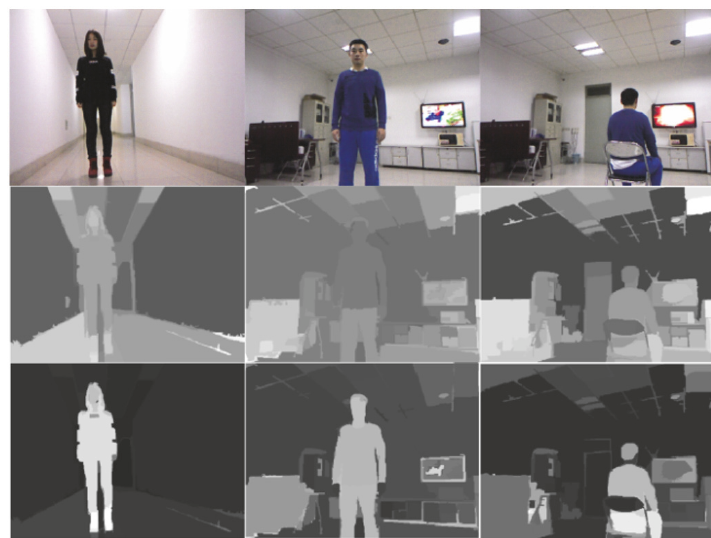
Figure 9: Comparison experiment with existing